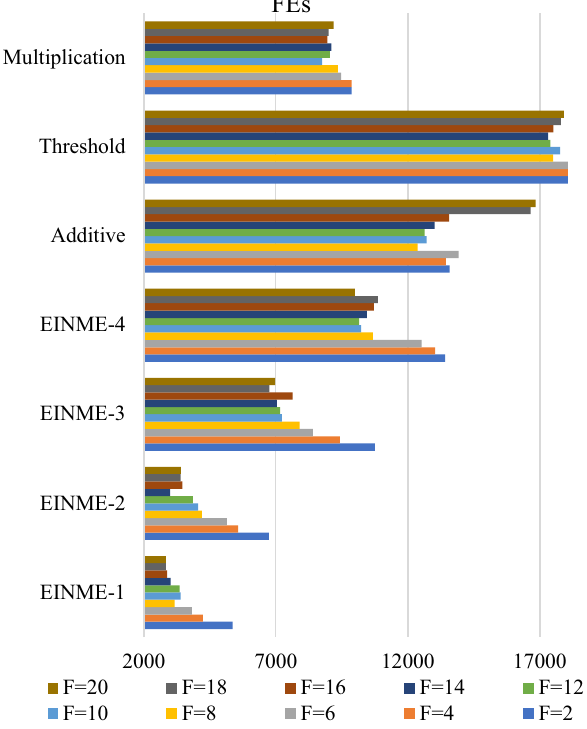
Fig. 6 Effect of parameter F on the FEs of MTHSA-DHEI